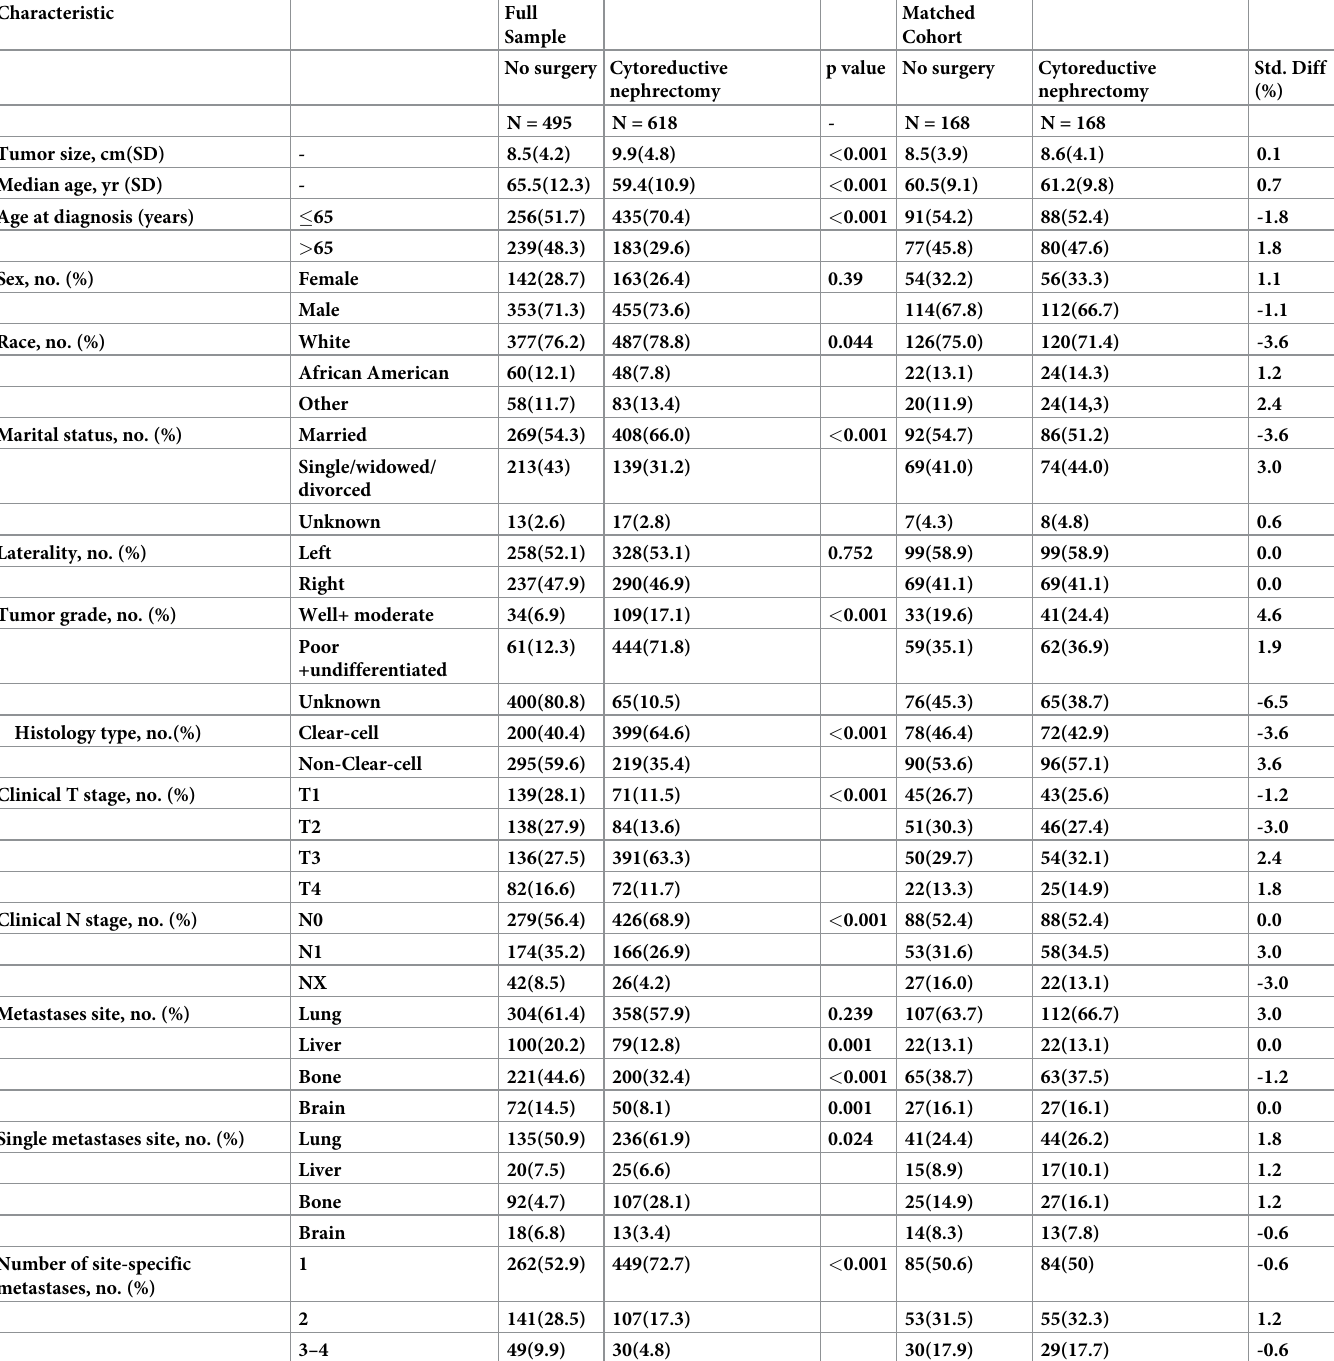
Table 1. Patient baseline demographics and pathological characteristics. Full sample and propensity score matched cohorts.